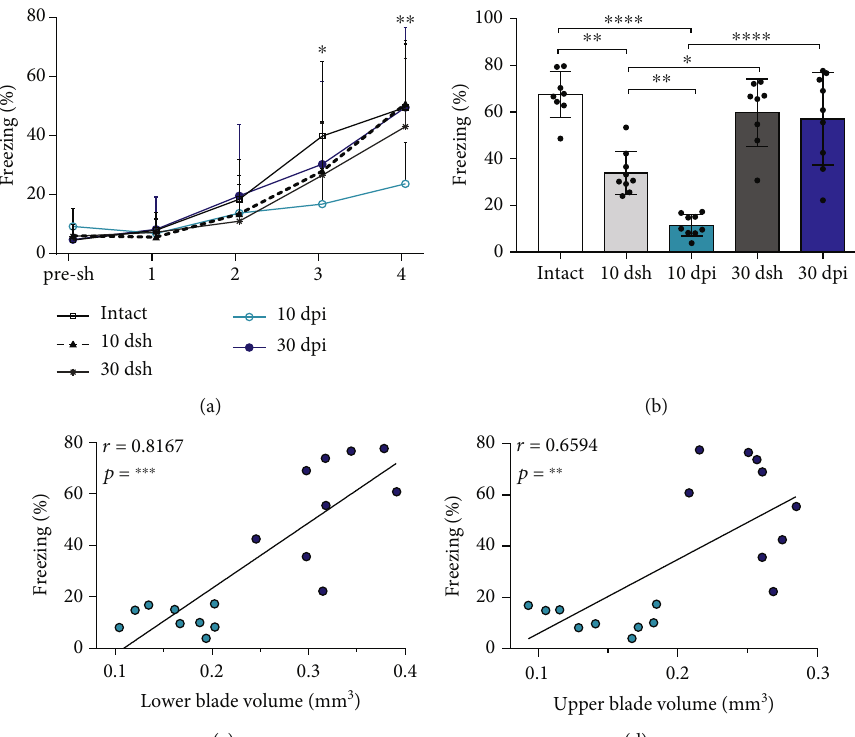
Figure 5: Contextual fear memory was impaired at 10 dpi but restored at 30dpi. (a) Learning curve for contextual fear conditioning. All groups, except mice at 10 dpi, showed progressive learning re fl ected by the increase in the percentage of freezing time across trials. Mice at 10dpi show lower freezing percentage time than intact mice on trials 3 and 4. Points represent the mean with SD for each group across trials (asterisks denote di ff erences from intact vs 10 dpi; two-way ANOVA followed by a Bonferroni ’ s post hoc test, = 43 : 07 , p < 0 : 0001 ). (b) Contextual fear memory retrieval. Mice at 10 dsh show lower freezing than intact mice, but more ( F ð 4 , 192 Þ freezing than mice at 10 dpi. At 30dpi, mice show similar freezing as intact and 30 dsh mice. The columns represent mean and SD for each group. Dots superimposed on the graph represent individual values (one-way ANOVA followed by Bonferroni ’ s post hoc test, F : 29 , p < 0 : 0001 ). (c, d) Graphs show the positive correlation between the volume of the (c) lower blade (Spearman correlation ð 4,38 Þ = 28 coe ffi cient, r = 0 : 8167 ; 95% con fi dence interval (0.5552 to 0.9313); n = 18 ) and the volume of (d) the upper blade (Spearman correlation coe ffi cient, r = 0 : 6594 ; 95% con fi dence interval (0.2644 to 0.8650); n = 18 ) with the percentage of freezing in lesioned mice. Light-blue circles correspond to 10dpi mice ( n = 9 ) and navy-blue circles to 30 dpi mice ( n = 9 ). For (a, b), intact n = 8 , 10 dsh n = 9 , 30 dsh n = 8 , 10dpi n = 9 , 30 dpi n = 9 . Asterisks indicate statistically signi fi cant di ff erences, ∗ p ≤ 0 : 05 ; ∗∗ p ≤ 0 : 01 ; ∗∗∗ p ≤ 0 : 001